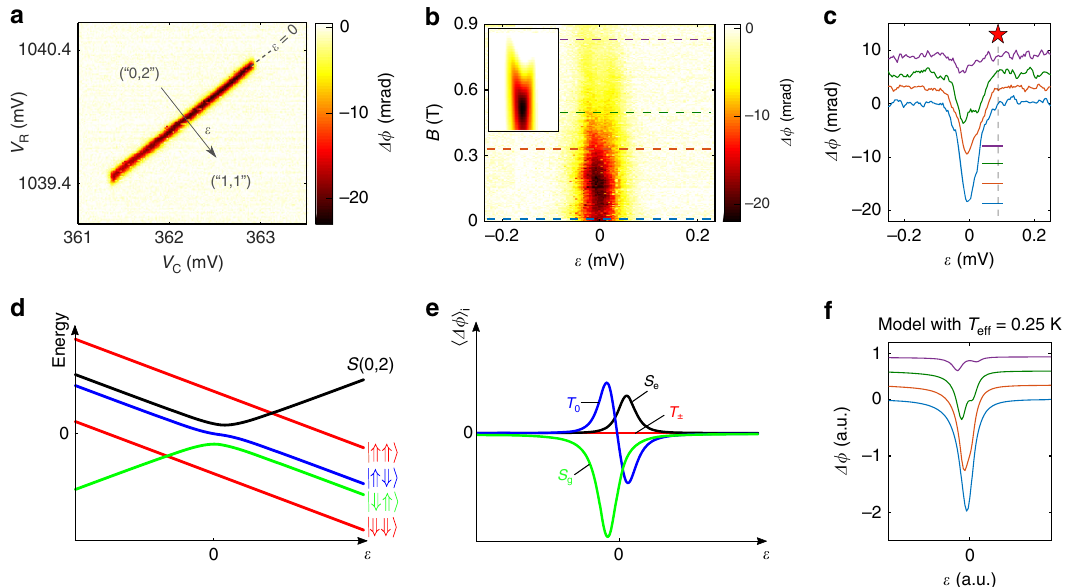
Fig. 2 Magnetospectroscopy of the double quantum dot. a Phase shift of the re fl ected signal as a function of V C and V R near the interdot transition line under study. The arrow indicates ε detuning axis. b Interdot dispersive signal as a function of a magnetic fi eld B oriented along the nanowire axis. The phase response diminishes with B , denoting a interdot charge transition of (0, 2) ↔ (1, 1) type. Inset: theoretical prediction of the dispersive response for a DQD model taking into account thermal spin populations, see Supplementary Note 3. c Line cuts of the plot in panel b) at the position of the dashed lines. Data are offset for clarity. d Schematic of the DQD energy levels close to a (0, 2) ↔ (1, 1) transition at fi nite B and for j g (cid:1) phase response 〈 Δ ϕ 〉 i with T eff = 0.25 K. 〈 Δ ϕ 〉 i is second derivative of the energy-level dispersion of state i in d ), weighted by the occupation probability. Here i labels the different DQD states, i.e. the singlets S g (green) and S e (black), and the triplets T 0 (blue), T − (red), and T + (red). f Qualitative phase shift resulting from the sum of all 〈 Δ ϕ 〉 i from e ). A double-peak structure emerges at suf fi ciently high B in qualitative agreement with the experimental data in c